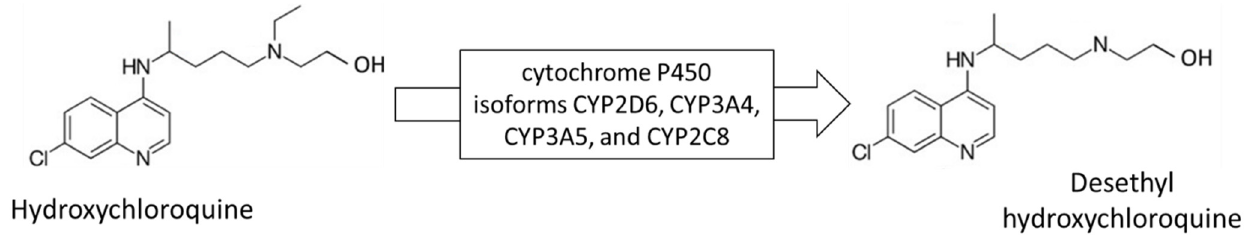
Figure 3. Structures of hydroxychloroquine and desethyl hydroxychloroquine.